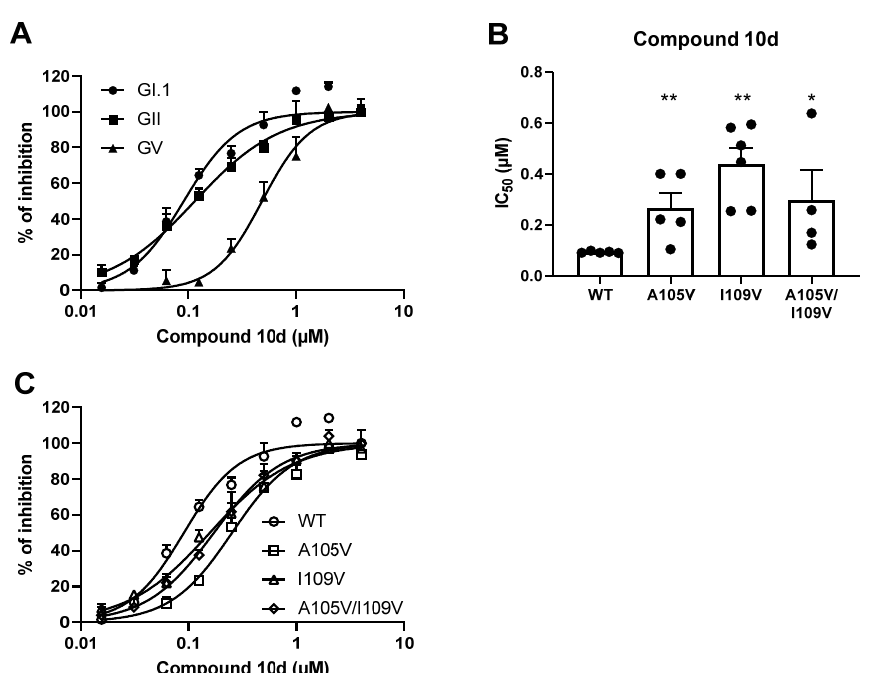
Figure 6. The susceptibility of mutated GI.1 proteases to compound 10d . ( A ) Dose–response inhi- bition curves showing the effect of compound 10d on the WT proteases. ( B ) IC 50 values of com- pound 10d on the WT or mutant GI.1 proteases. ( C ) Dose–response inhibition curves showing the effect of compound 10d on the WT or mutant GI proteases. Mean values ± SEM are presented, Mann–Whitney test, ** p < 0.01, * p < 0.05.